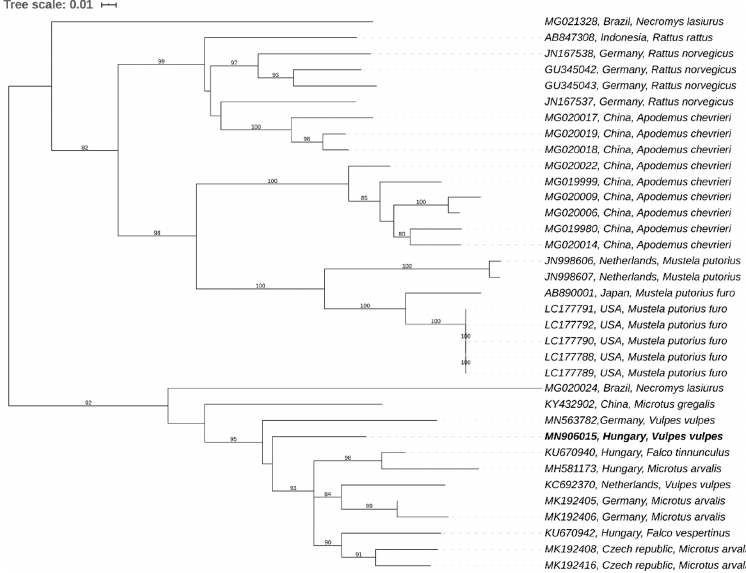
Figure 1. The evolutionary history of the partial RdRp nucleotide sequences was inferred using the Neighbor-Joining method. The optimal tree with the sum of branch length = 3.83355834 is shown. The confidence probability (multiplied by 100) that the interior branch length is greater than 0, as estimated using the bootstrap test (1000 replicates is shown next to the branches. The tree is drawn to scale, with branch lengths in the same units as those of the evolutionary distances used to infer the phylogenetic tree. The evolutionary distances were computed using the Kimura 2-parameter method and are in the units of the number of base substitutions per site. The rate variation among sites was modeled with a gamma distribution (shape parameter = 4). This analysis involved 36 nucleotide sequences. Codon positions included were 1st + 2nd + 3rd + Noncoding. All positions with less than 95% site coverage were eliminated, i.e., fewer than 5% alignment gaps, missing data, and ambiguous bases were allowed at any position (partial deletion option). There was a total of 271 positions in the final dataset. Evolutionary analyses were conducted in MEGA X. The sequence of interest is mentioned in